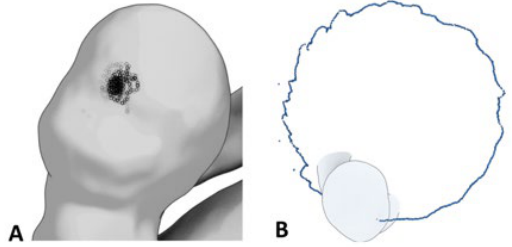
Figure 4 | (A) Accumulated motion of a single fixed point, over cardiac cycle. (B) Same fixed point traced out in a